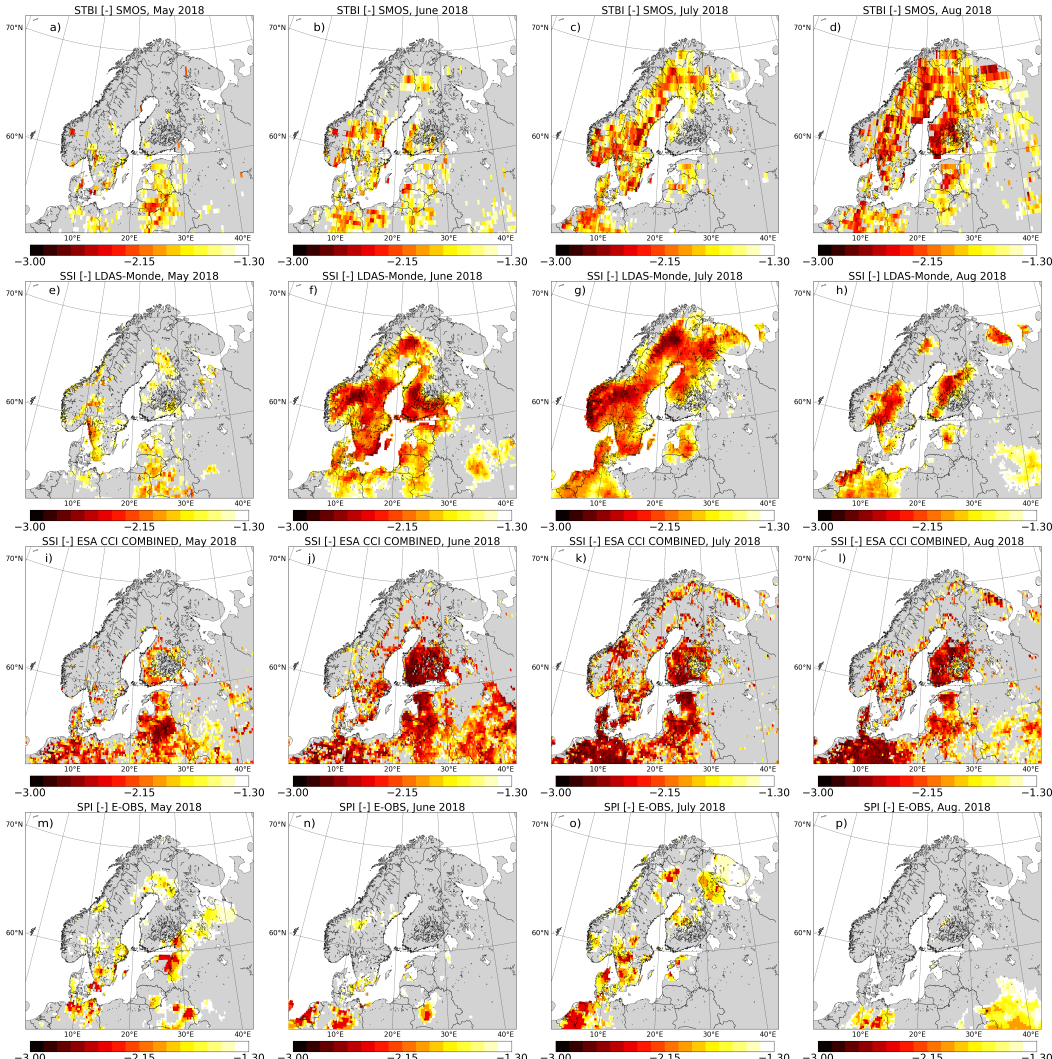
Figure 5. Regions with severe drought conditions, drought index < − 1.3 for May, June, July and August. Red regions are severe drought conditions, while yellow and white are regions with less severe drought conditions. Grey colour indicates regions where the drought indices are larger than −